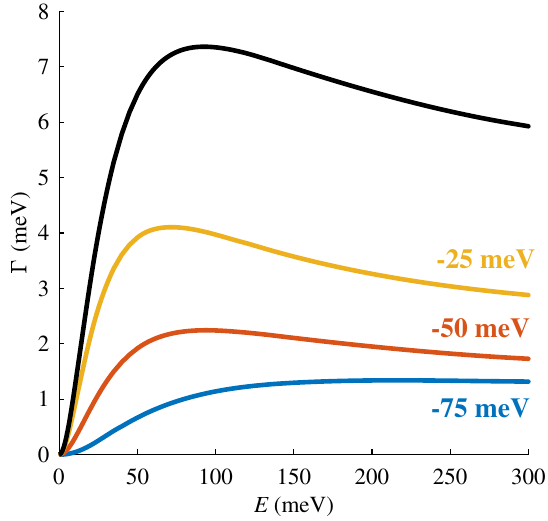
FIG. 12. Relaxation rate for individual subbands. We show contributions to Γ by exciting the Fermi sea of different subbands: the lowest subband ( − 75 meV below ε , blue), two higher F occupied subbands ( − 50 meV in red and − 25 meV in yellow), and the sum of all three contributions (black). The energy denotes the bottom of the subbands, and we use energy spacing and dispersion extracted from the experiment.